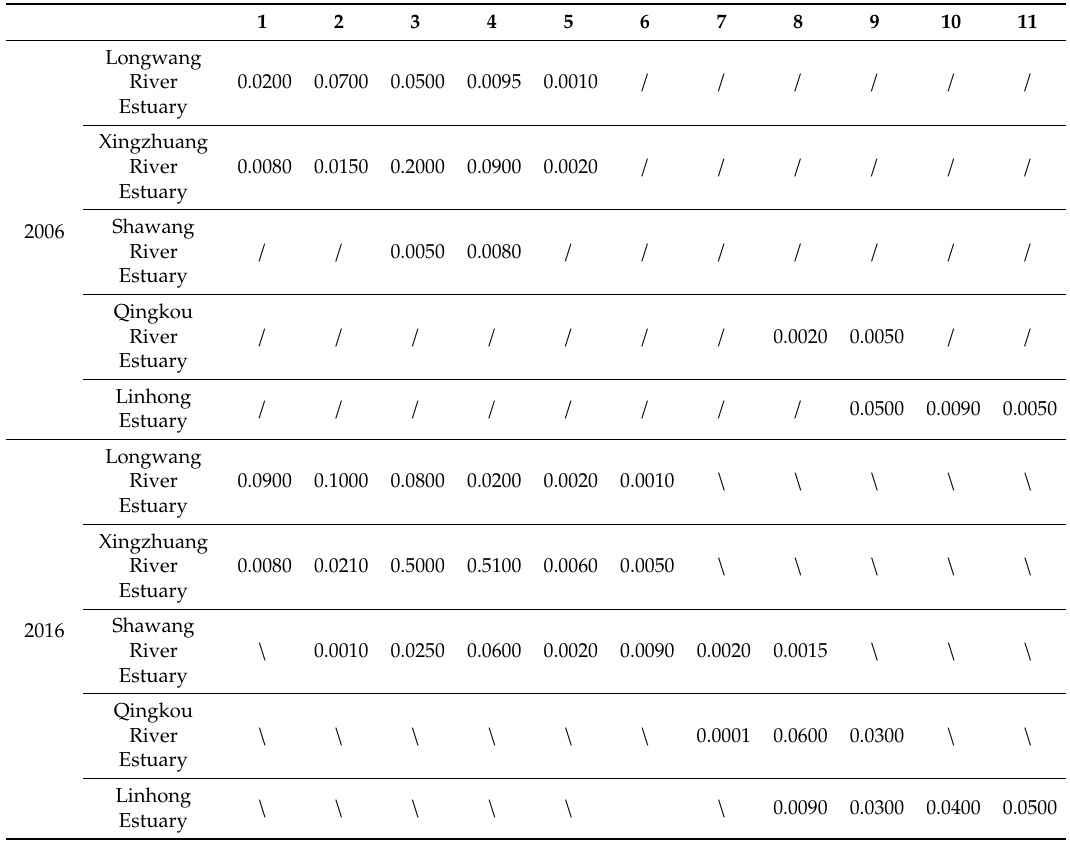
Table 3. The response coe ffi cient of the coastal estuaries in Haizhou Bay in 2006 and